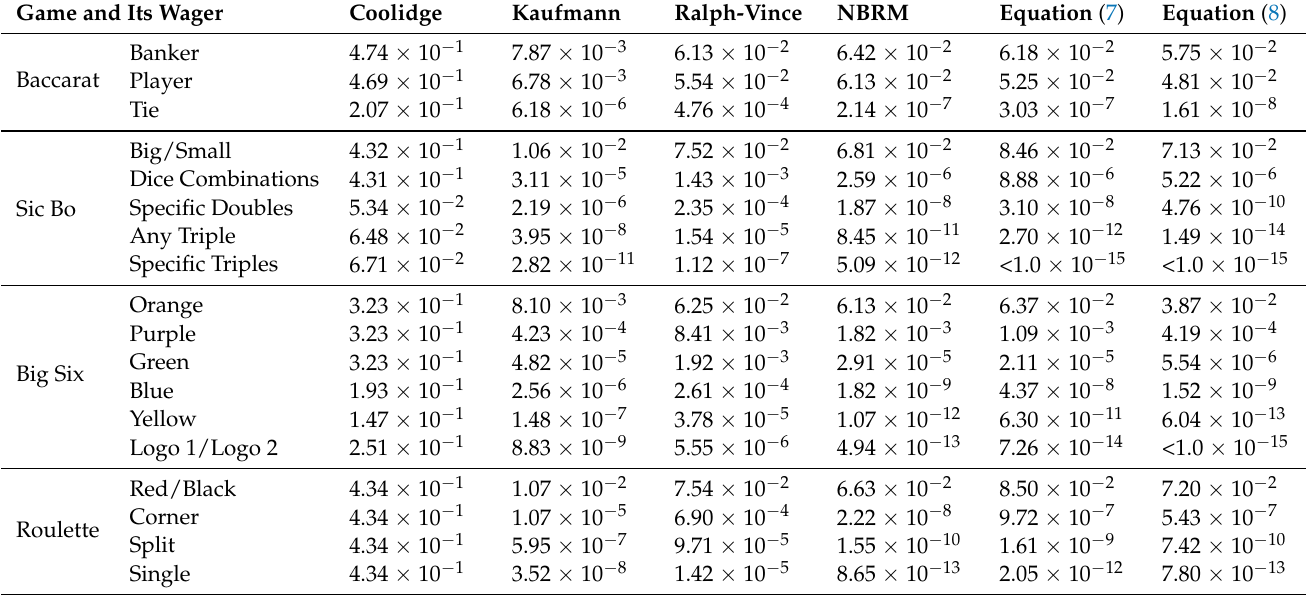
Table 5. ROR probabilities estimated by different models. Please refer to the above tables for variable